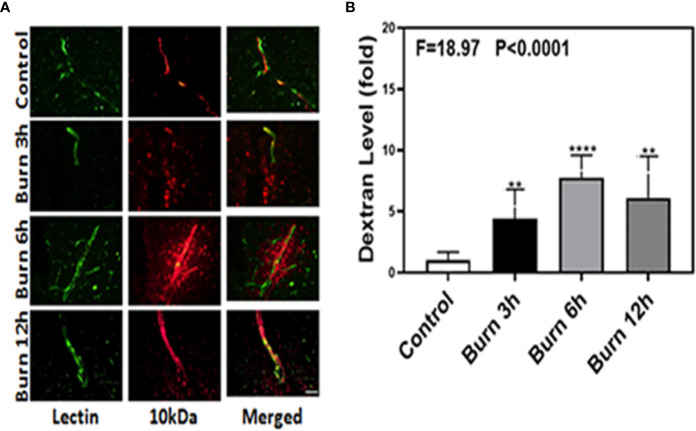
Burn increases blood–brain barrier permeability to 10-kDa dextran in mice. (A). Immunostaining of blood vessels (lectin, green, the first column) and dextran (10-kDa dextran, red, the second column) of the brain section following the control condition in mice (the first row), the burn in mice after 3 h (the second row), the burn in mice after 6 h (the third row), and the burn in mice after 12 h (the fourth row). The third column is the merged image of the first and second columns. The red spots (non-overlap area) in the third column indicate the dextran that is not inside the blood vessel (extravascular dextran). N = total of 90 slides from six mice in each group. Scale bar, 50 µm. (B). Spectrophotometric quantification of brain dextran shows that the burn increases extravascular 10-kDa dextran level in the mouse brain tissues as compared to that in the control condition (white bar)at 3, 6, and 12 h (black, gray, and dot bar) after burn and the highest level is at 6 h (gray bar) after burn. N = 6 in each group. (**p < 0.01, ****p < 0.0001).